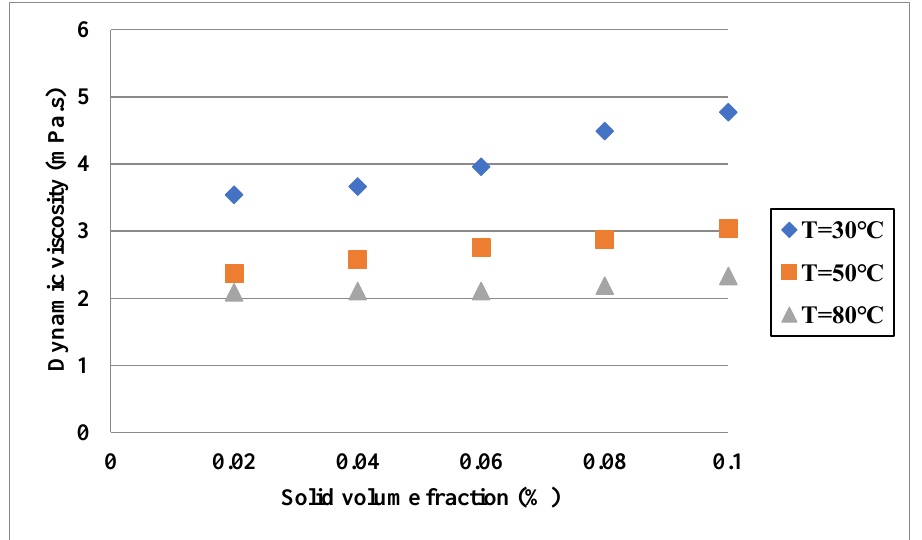
Figure 8. Effect of volume concentration on DV of TiO 2 -Al 2 O 3 /water-EG. Adapted from Ref. [81]. Aside from the hybrid nanofluids with two dissimilar materials, the DV of the ones with three dissimilar materials has been investigated by some researchers. For instance,